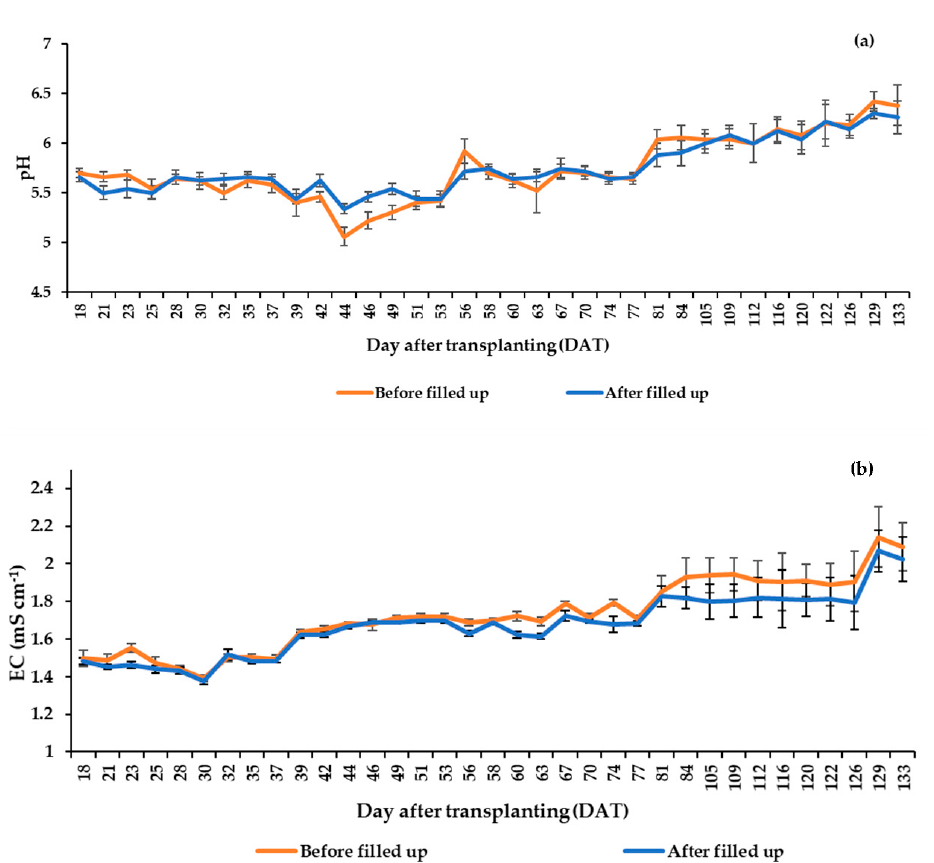
Figure 6. Nutrient solution pH ( a ) and EC ( b ) before and after tank filling during the growth cycle under control (NL), R + B + FR, and R + B light conditions. Vertical bars represent ± standard deviation of mean values.